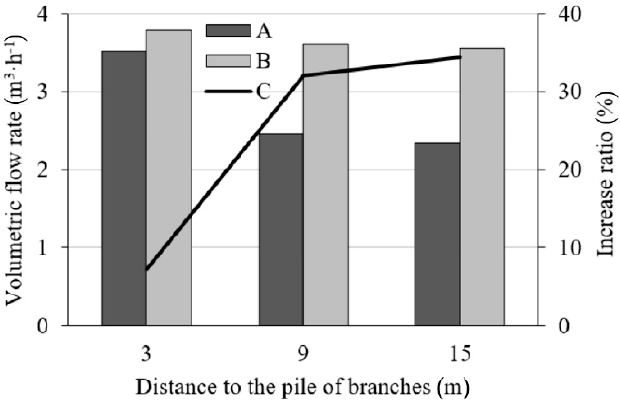
C—increase ratio of mass productivity when the number of operators was increased to two. Forests 2020 , 11 , x FOR PEER REVIEW